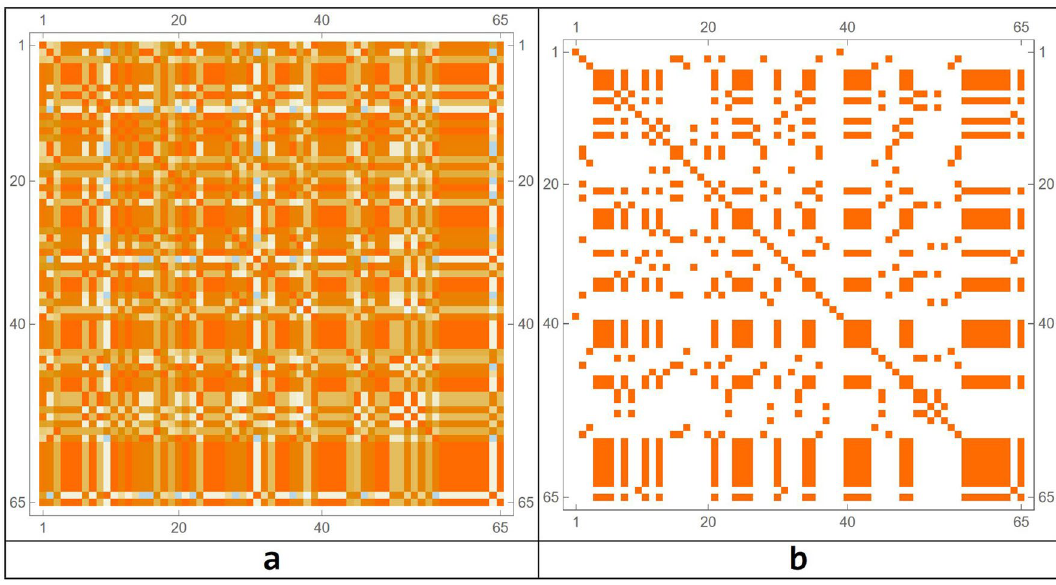
Figure 12. Correlation matrices for all nodes ( a ) and for the emerging circuits ( b